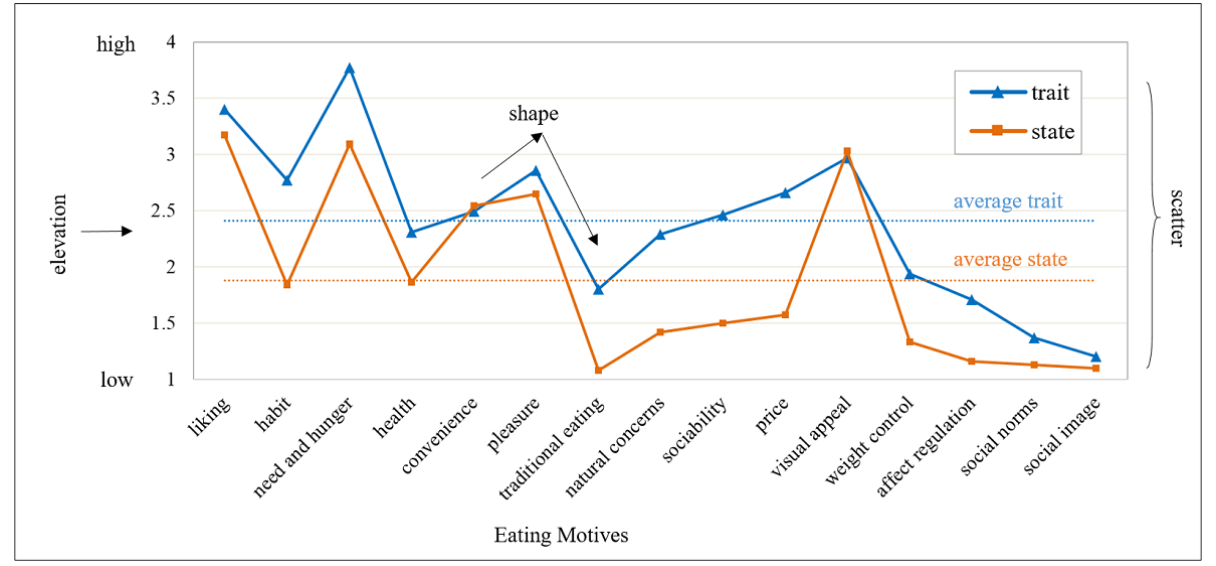
Figure 3. Average (typical) profile of the 15 trait and state eating motives with ICC de =0.52, P <001. Ratings ranged from (1) “strongly disagree” to (4) “strongly agree.” Motives are arranged according to their rank order observed for The Eating Motivation